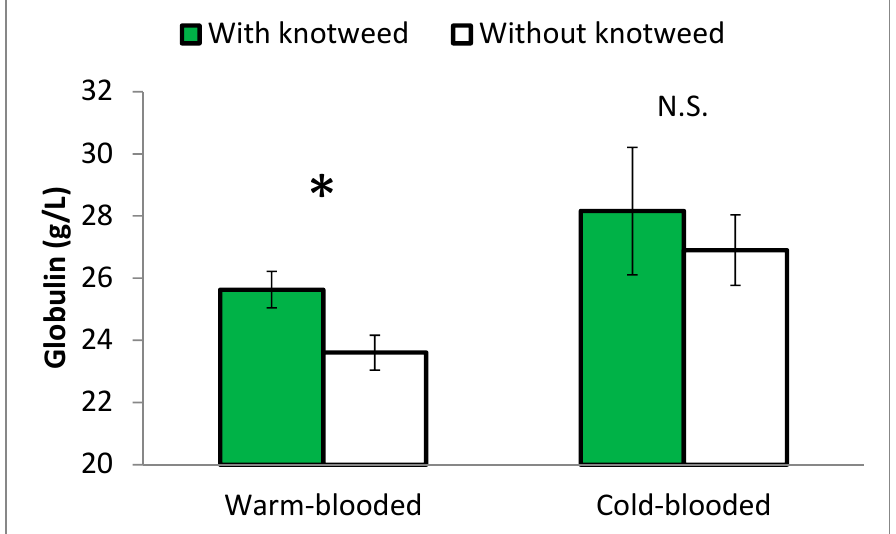
Figure 3. Globulin content in the blood of stallions of all ages. The comparison was between warm- blooded and cold-blooded stallions fed with and without knotweed, Experiment 1. Means ± SEM. Statistically different values at p ≤ 0.05 are marked with *; N.S. = non-significant difference.